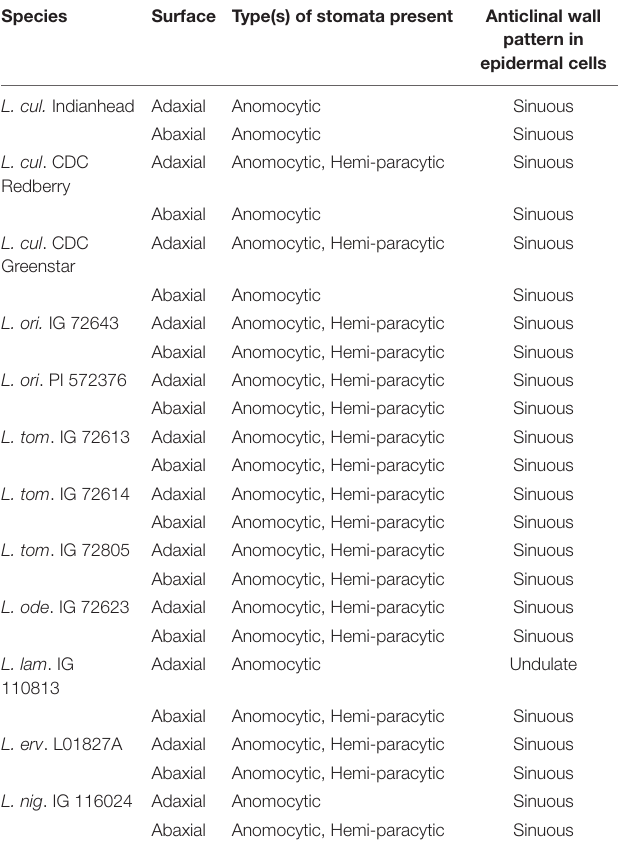
TABLE 2 | Qualitative stomatal and epidermal cell traits in 12 wild and cultivated lentil genotypes. Species Surface Type(s) of stomata